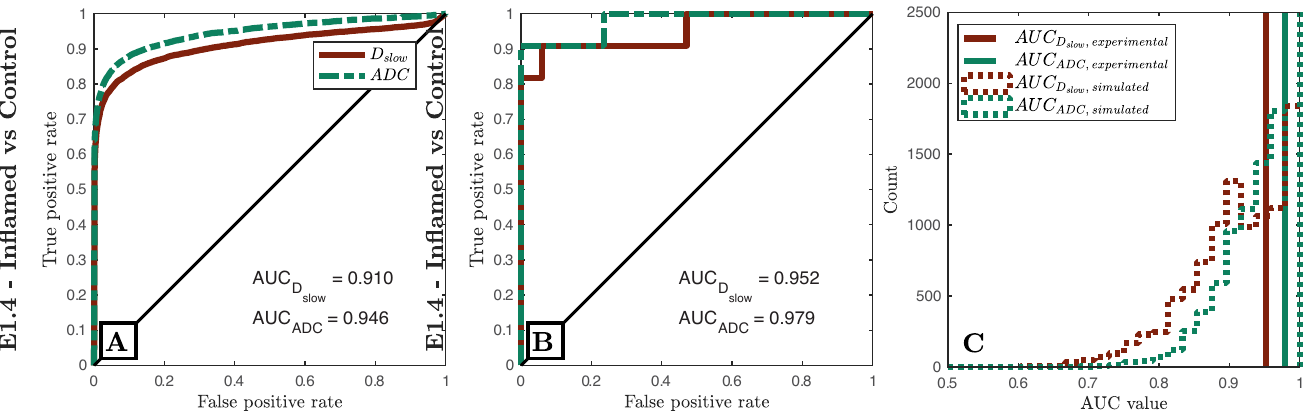
Fig 3. Simulated (first column) vs clinical (middle column) ROC curves for Bray’s dataset (E1.4). The third column compares clinical AUC values (vertical lines) to simulated AUC values (distributions) when sub-sampling simulated data to match clinical study sizes. As in Fig 2, ROC curves are qualitatively similar; the relative performance (AUC values) of dMRI models are equal; all AUC values are in numerical agreement once clinical sample size is accounted